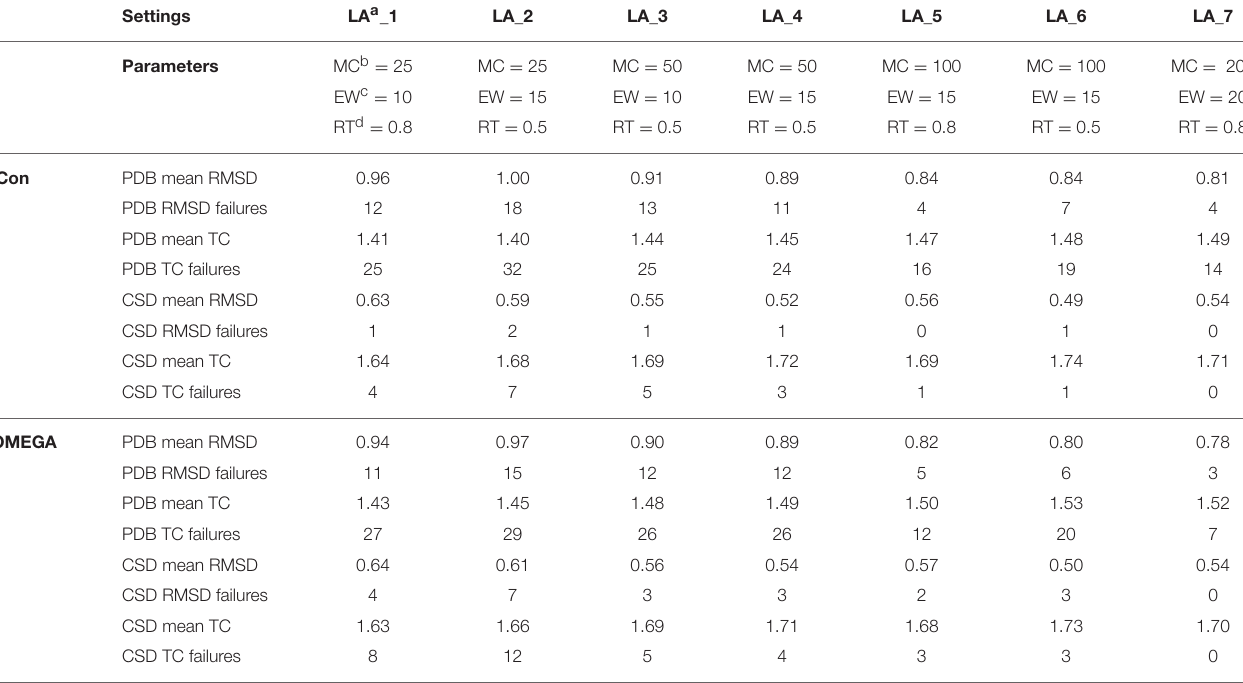
TABLE 2 | Mean RMSD and TC score values obtained for PDB and CSD data set compounds by using iCon and OMEGA with low accuracy settings.